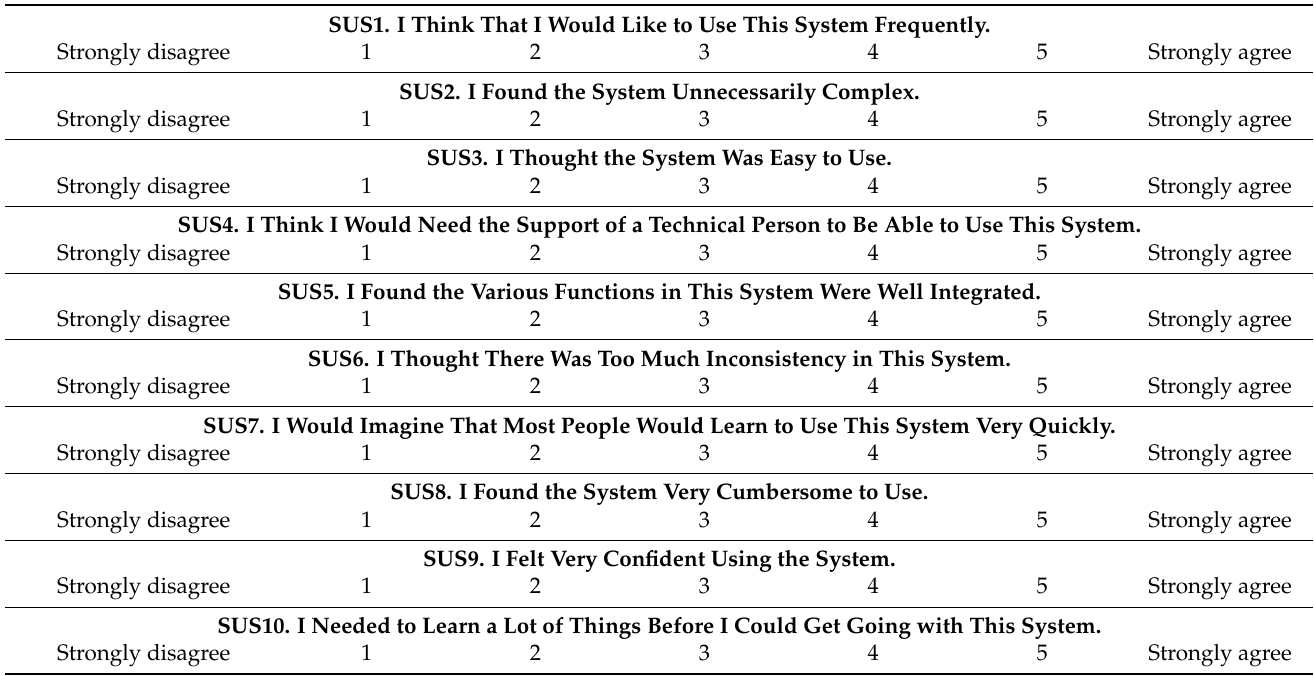
Table 7. System Usability Scale